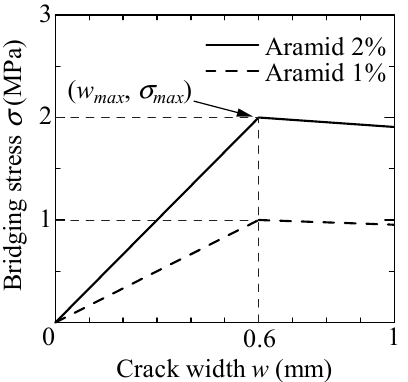
Figure 15. Bridging law model of aramid-FRCC used for evaluation.